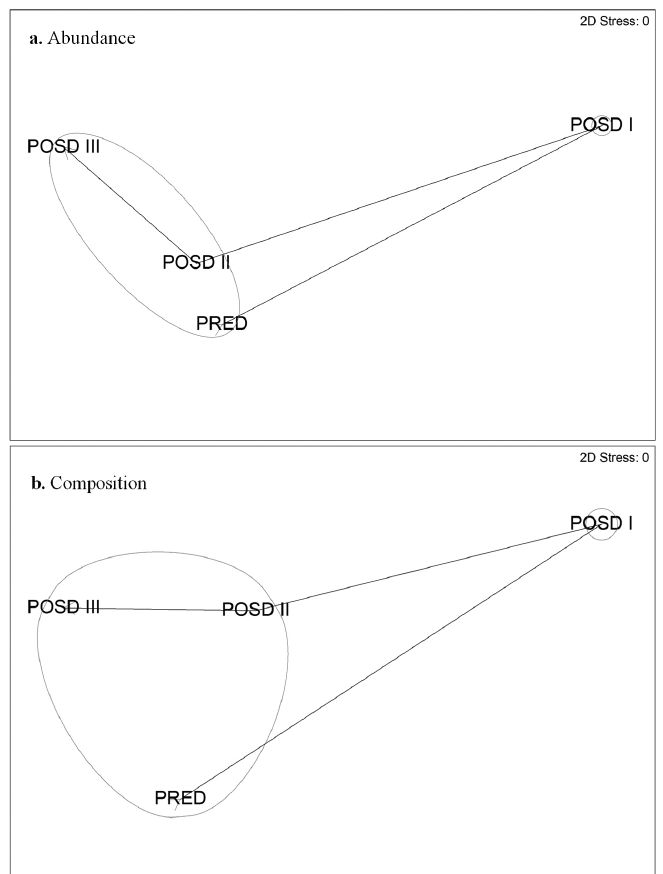
Figure 1. Non-Metric Multidimensional Scaling associated with Cluster Analysis evidencing groups formed from the pre-disturbance (PRED) and post-disturbance I, II, and III (POSD I, POSD II, and POSD III, respectively) periods, using Bray-Curtis index for abundance (a) and composition (b). Circles represent groups with 55% similarity. Lines indicate temporal sequence and direction of the stream community recovery